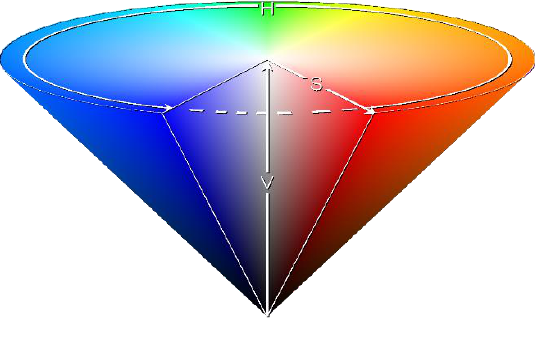
Fig. 7. Visual representation of the HSV